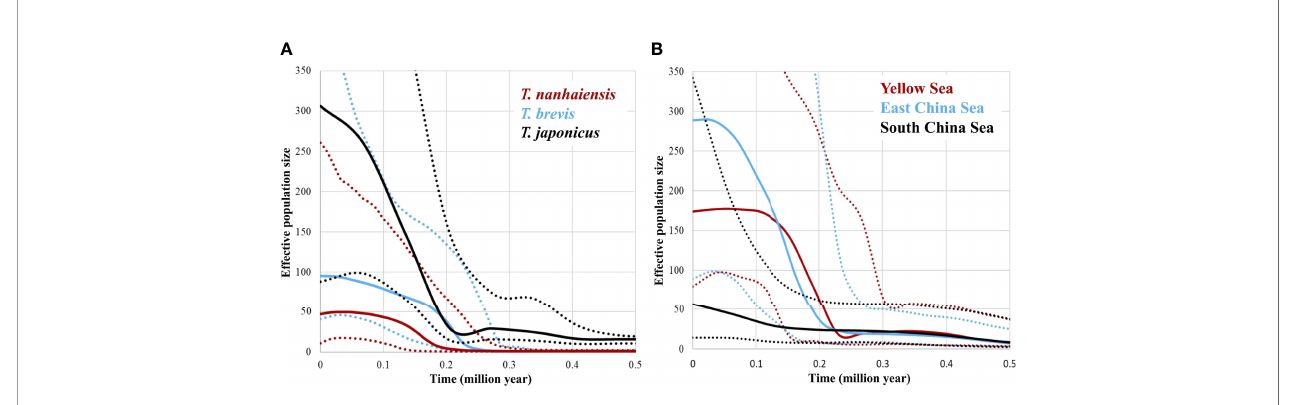
FIGURE 3 | Bayesian skyline plots of the effective population sizes through time in (A) Trichiurus japonicus , T. nanhaiensis , and T. brevis , and (B) three metapopulations (Yellow Sea, East China Sea, and South China Sea) of T.